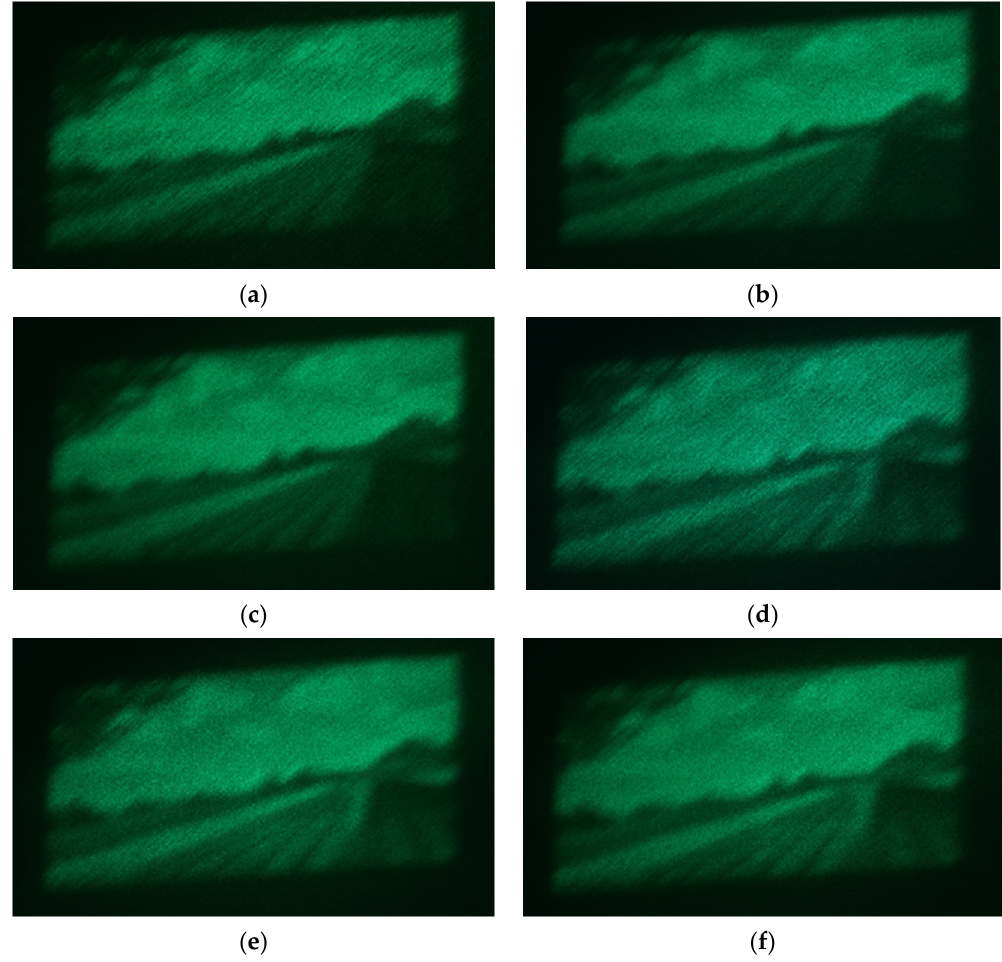
Figure 10. Optical reconstruction results: the methods used in ( a – f ) correspond to Table 2. The brightness and contrast were adjusted to make the reconstructed image clearer.